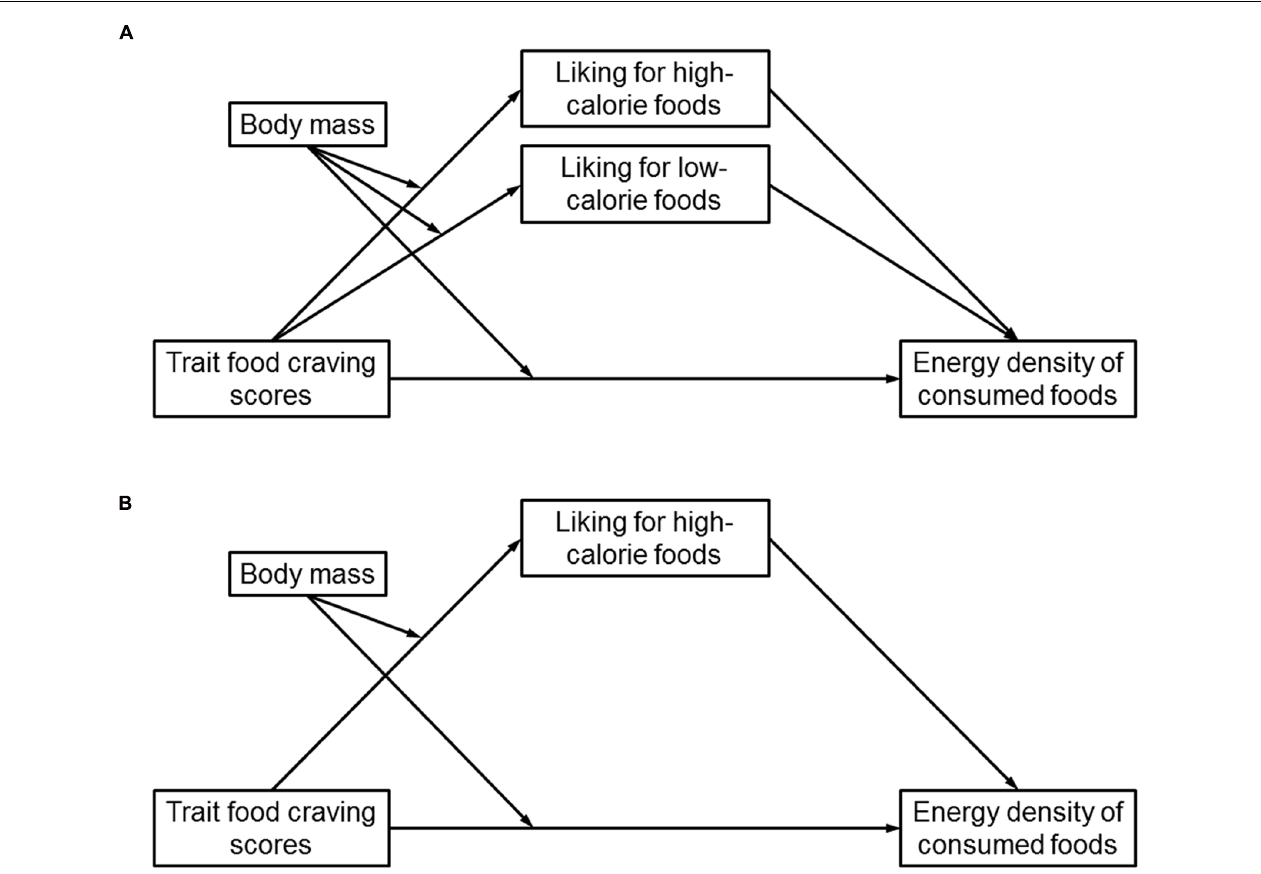
FIGURE 1 | (A) Conceptual moderated mediation model, in which trait food craving scores, body mass, and their interaction were used as predictors of liking for high- and low-calorie foods (as parallel mediators) and mean energy density of consumed foods. (B) Empirical moderated mediation model, in which body mass moderated the indirect effect of trait food craving scores on mean energy density of consumed foods via liking for high-calorie foods. Liking for low-calorie foods did not mediate the interactive effect of trait food craving scores and body mass on mean energy density of consumed foods.